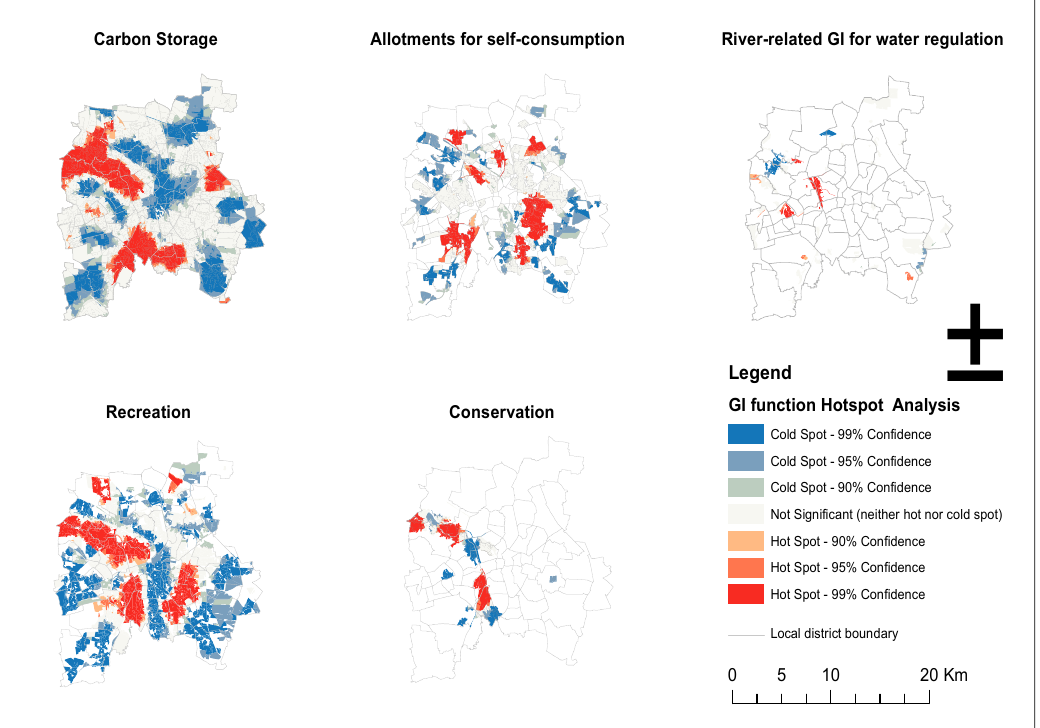
Figure 7. Spatial distributions of hot/cold spots of GI functions.